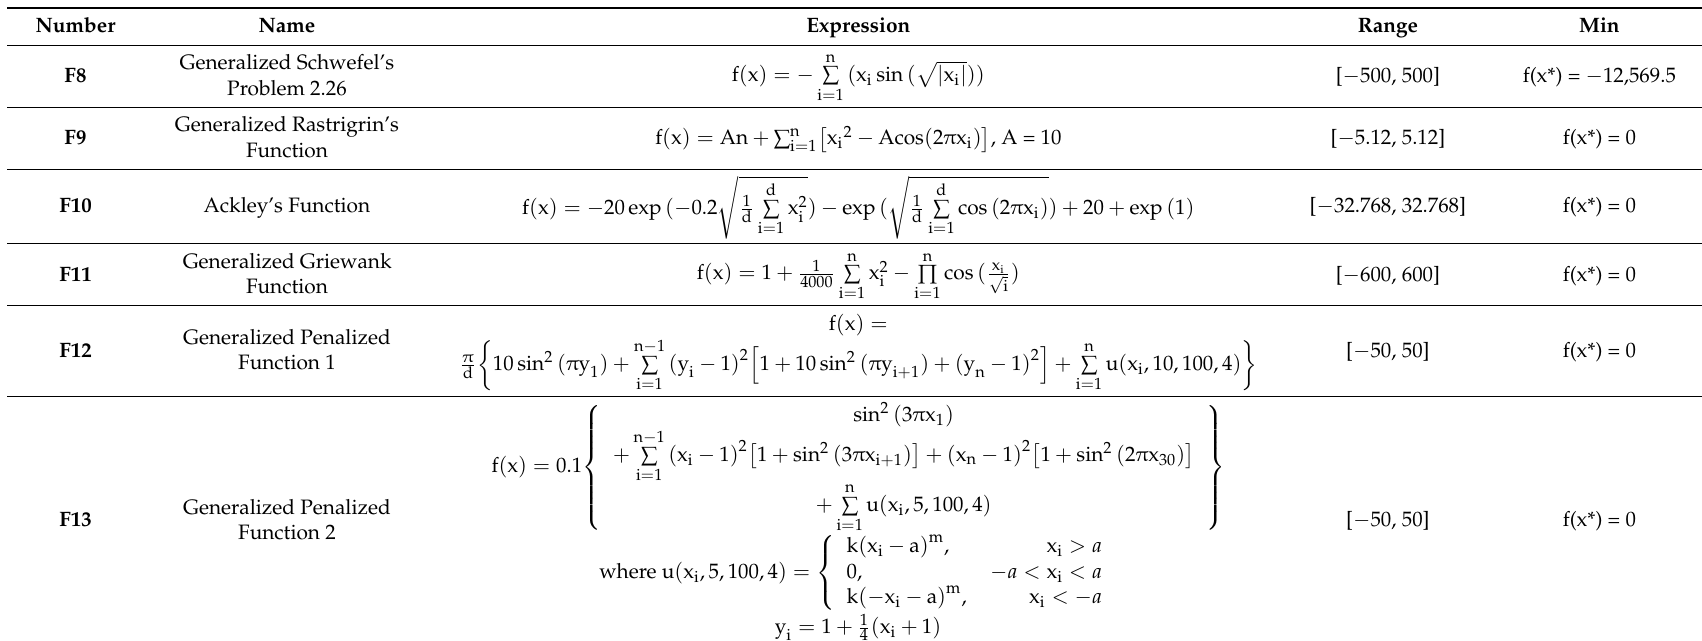
Table 3. Multimodal test functions considered for